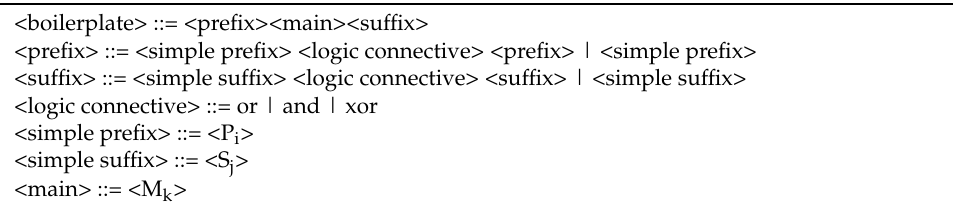
Table 2. Boilerplate Language Syntax.